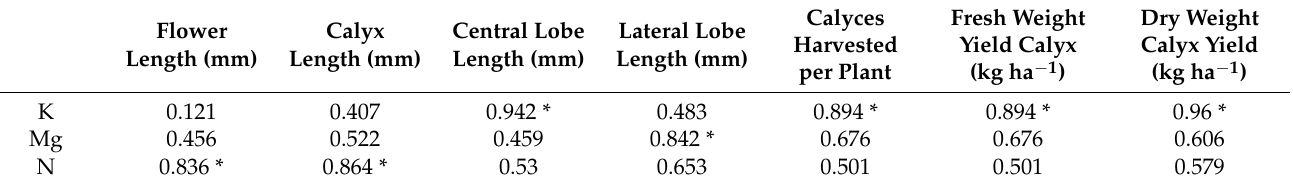
Table 6. Main Pearson correlation coefficients between mineral content and morphological character- istics of roselle